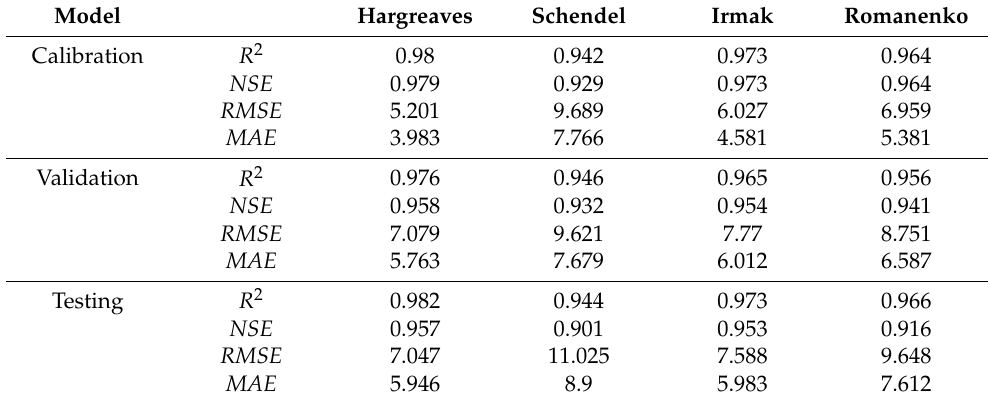
The R 2 , NSE , RMSE , and MAE values of the studied empirical equations at different stations are given in Figure 3. In general, the Hargreaves equation performs best at all stations, followed by the Irmak equation. The Romanenko equation is slightly better than the Schendel equation at most stations. The lowest NSE value and highest RMSE value are found at the Daxian station, which has higher precipitation (1228.38 mm) than those of other stations (most < 1000 mm). With the lowest RMSE and MAE values and the highest R 2 and NSE values, Lveyang station achieves the best performance.